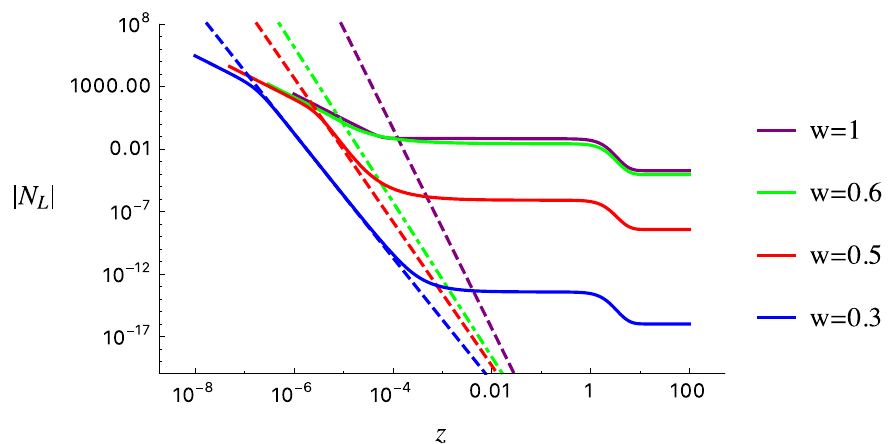
Figure 19 . Dynamical evolution of the gravitationally-induced lepton number asymmetry N L ( z ) for e(cid:11)ective equation of state parameters w = 0 : 3, 0 : 5, 0 : 6 and 1 with z (cid:3) = 0 : 1. The corresponding equilibrium values N eq are shown as the dot-dashed lines. Note the universal N L ( z ) (cid:24) 1 =z 2 L behaviour at ultra-high temperatures where the evolution term W ( z ) dominates in the Boltzmann equation. Decoupling from N eq occurs earlier for higher values of w , resulting in a larger (cid:12)nal L asymmetry. The parameters here are M 1 = 10 10 GeV, K = 5, with M 2 = 10 12 GeV, Im K 12 = (4 (cid:25) ) 2 = 5 (cid:2) 10 (cid:0) 4 and no hierarchy enhancement, p =